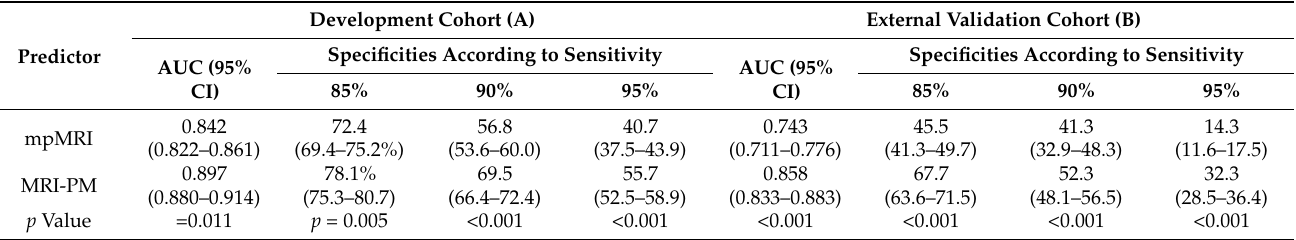
Table 3. Efficacy of mpMRI and MRI-based predictive model analysed from the AUCs and specificities corresponding to the 85%, 90% and 95% sensitivity thresholds for csPCa, in development cohort (A) and external validation cohort (B).